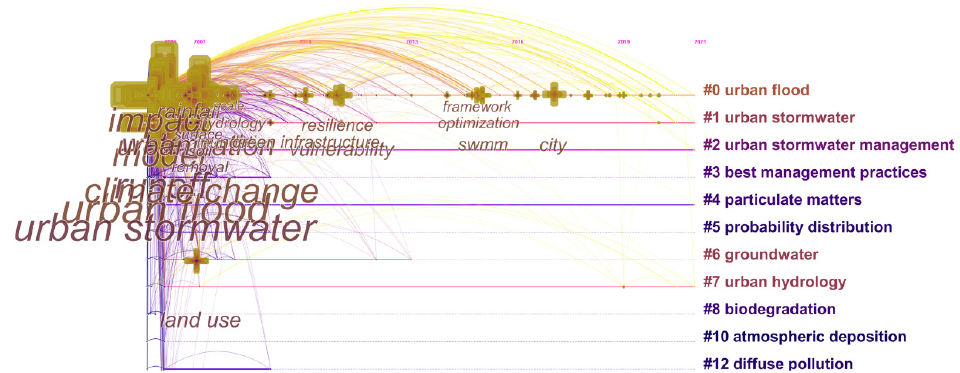
Figure 10. A timeline view of keywords in CiteSpace.